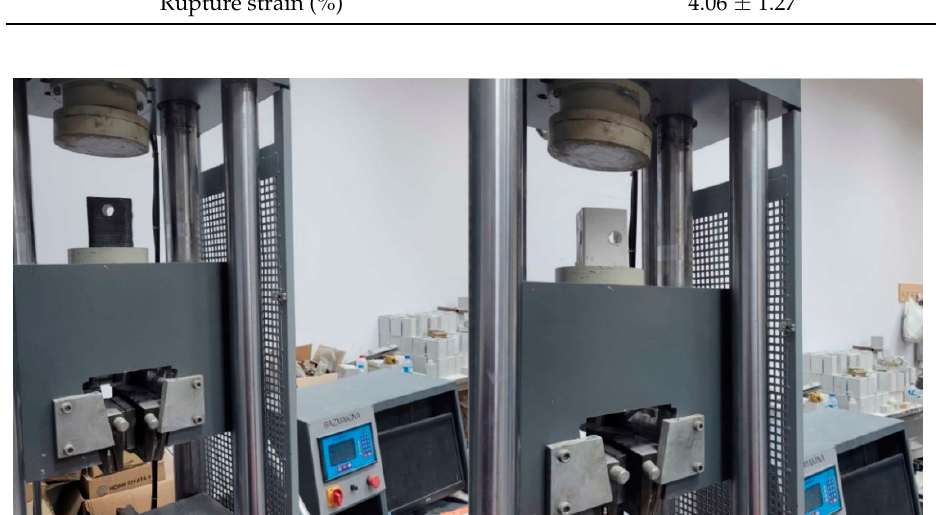
Figure 1. Specimens with same opening size with different location, dimensions are mm.